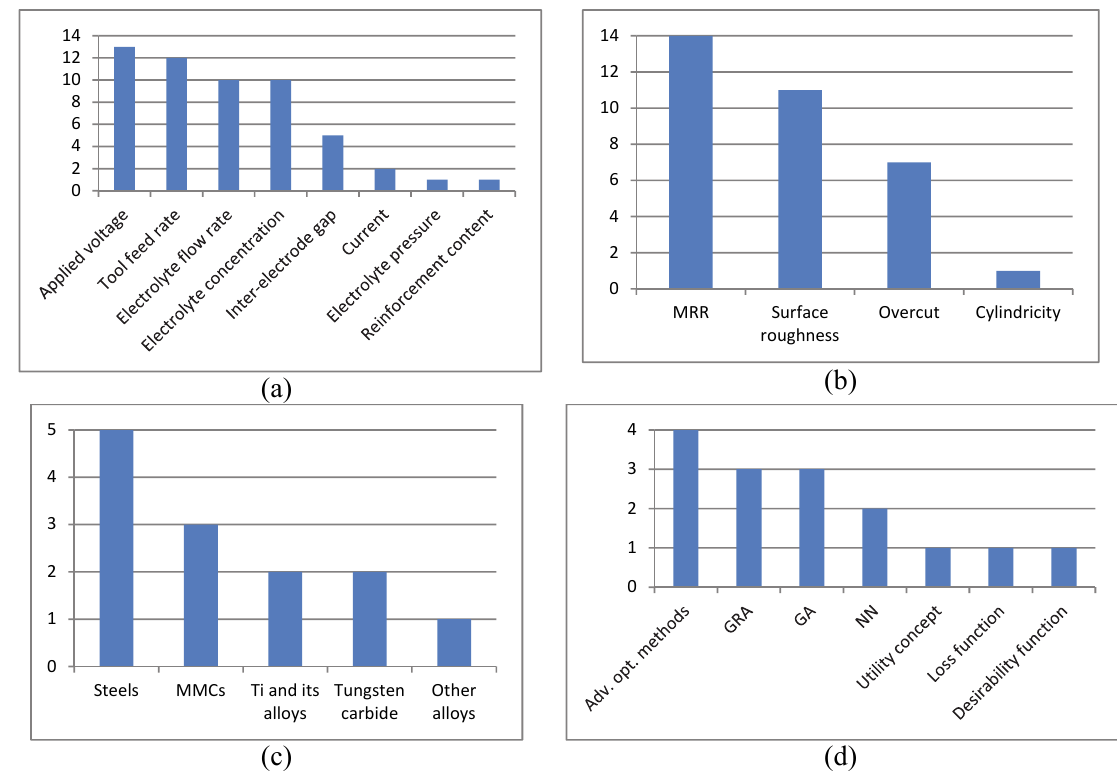
Fig. 1 Analysis on the parametric optimization of ECM